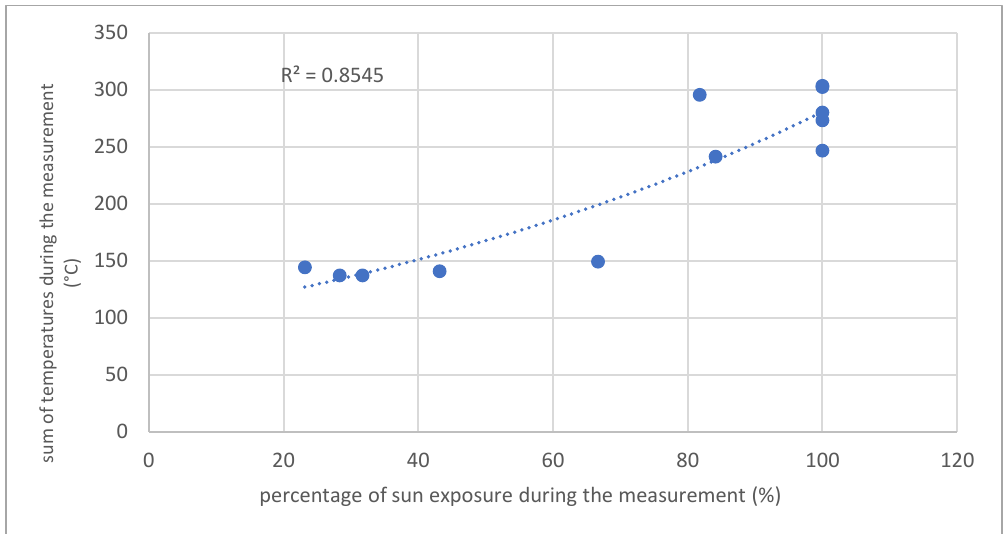
Figure 10. Dependence between the sum of temperatures and the percentage of sun exposure during the measurement period on 18 August 2019. Table 2. Multiple regression parameters of model for surface temperature estimation.